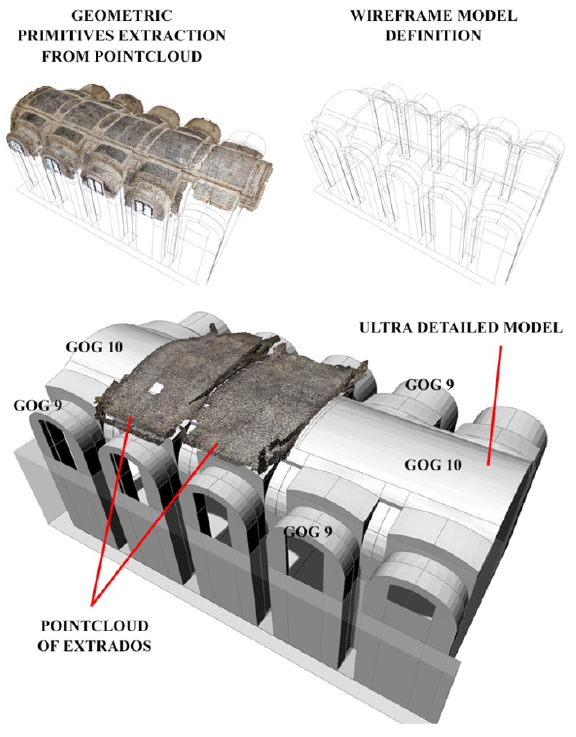
Figure 10. Digital Workflow of the vault 3D model of the Italian Cultural Institute with the indication of the parts realized by means of GOG 9 and GOG 10